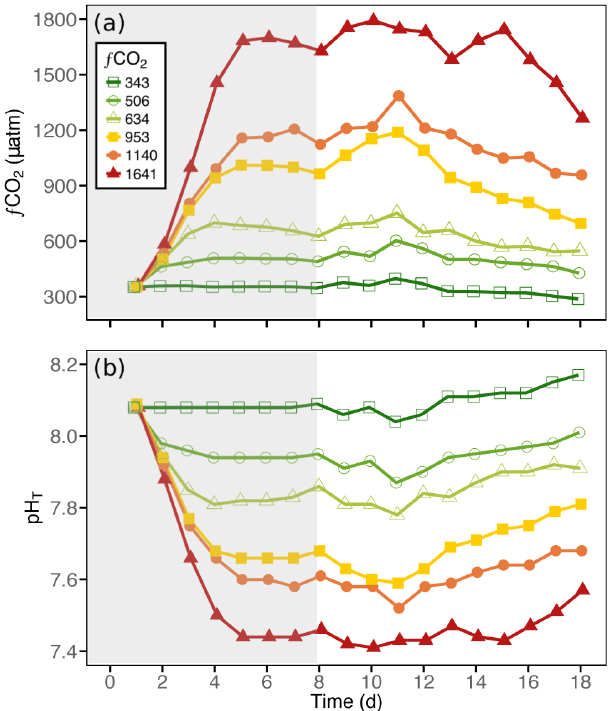
Figure 2. The (a) f CO 2 and (b) pH T conditions within each of the minicosm treatments over time. Grey shading indicates CO 2 and light acclimation